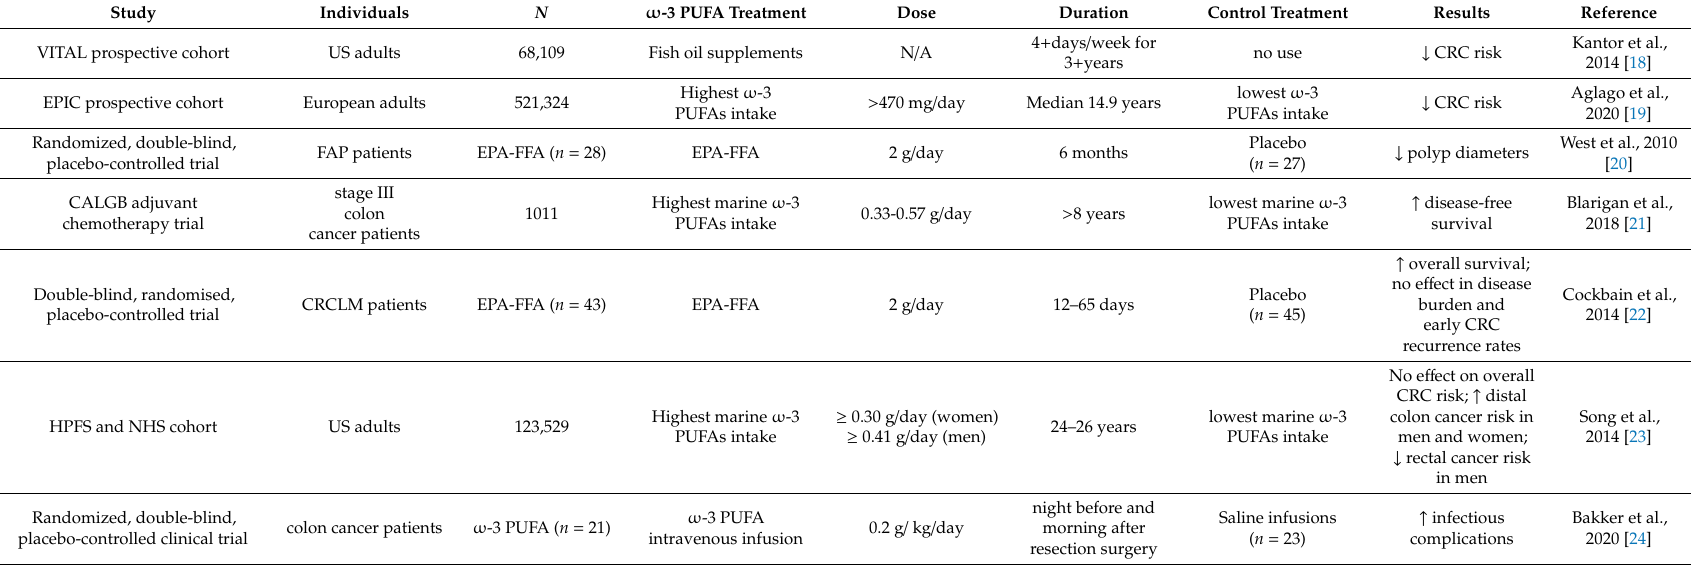
Table 1. Recent epidemiological and clinical studies of ω -3 polyunsaturated fatty acid (PUFA) supplementation for the prevention / treatment of colorectal cancer